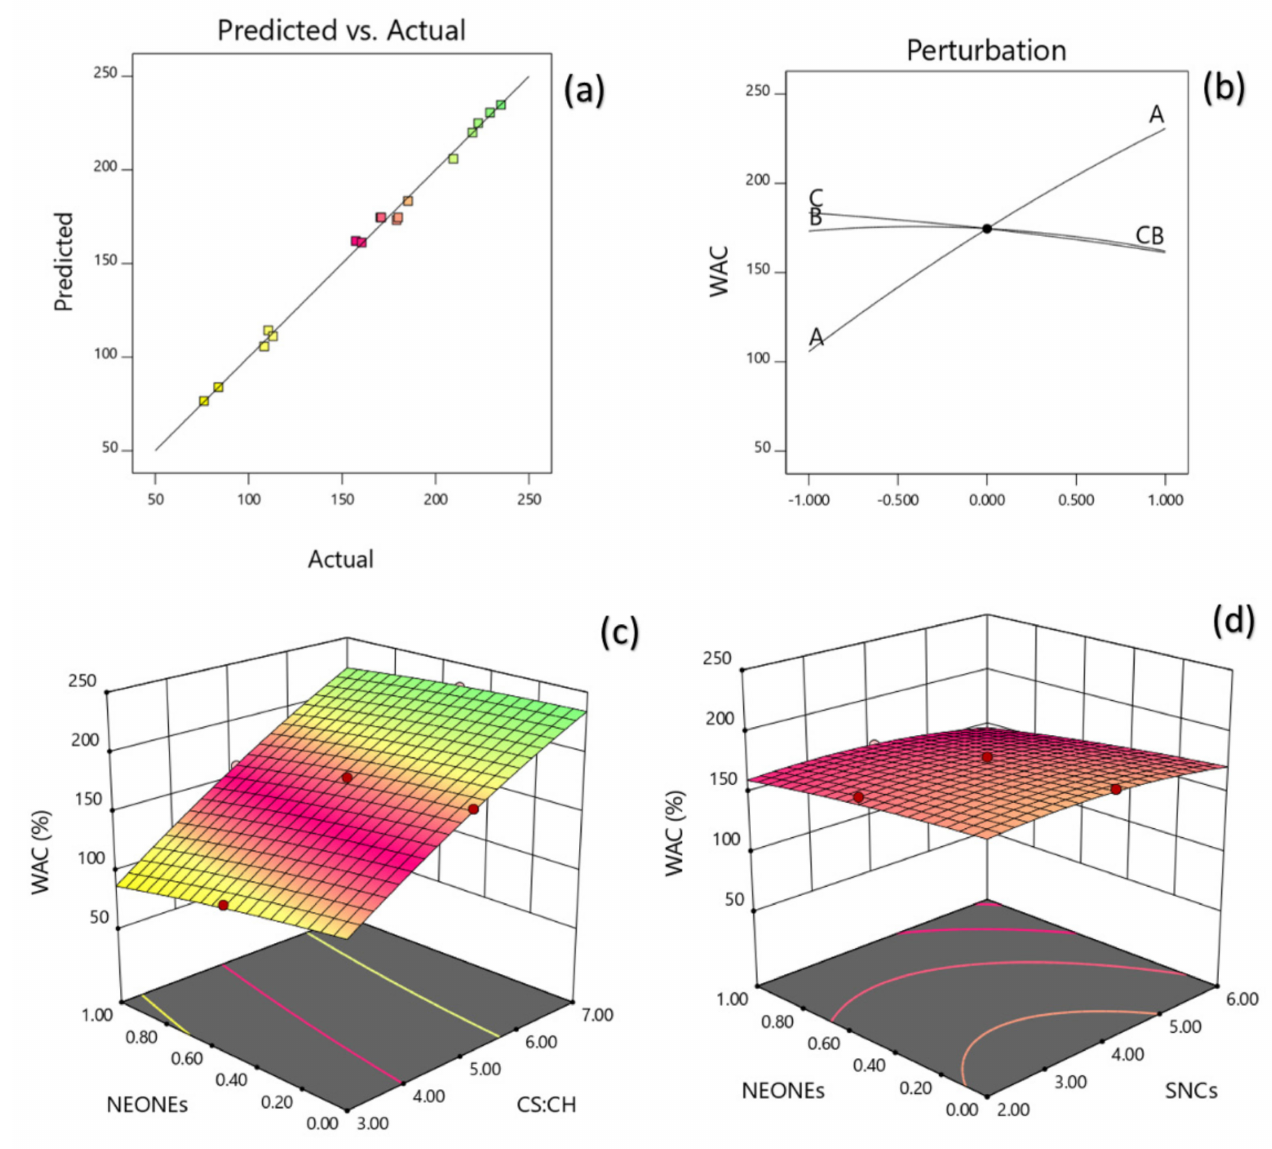
Figure 3. Counter and perturbation graphs ( a , b ), the interaction between CS:CH and SNCs concentration and also interaction between SNCs and NEONEs concentration on WAC of the produced film ( c , d